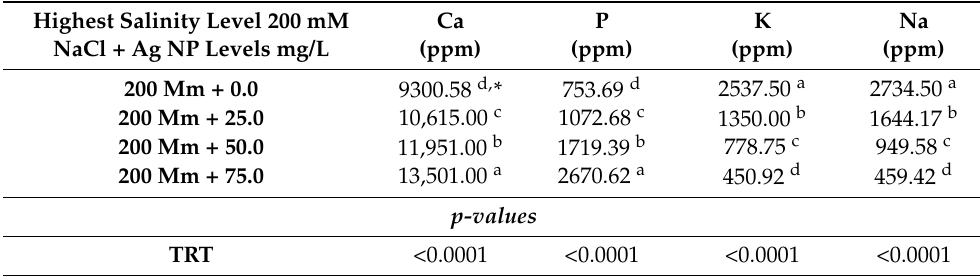
Table 6. The contents of Ca, P, K, and Na for Q6 quinoa plantlets grown under the highest NaCl level after adding different levels of Ag